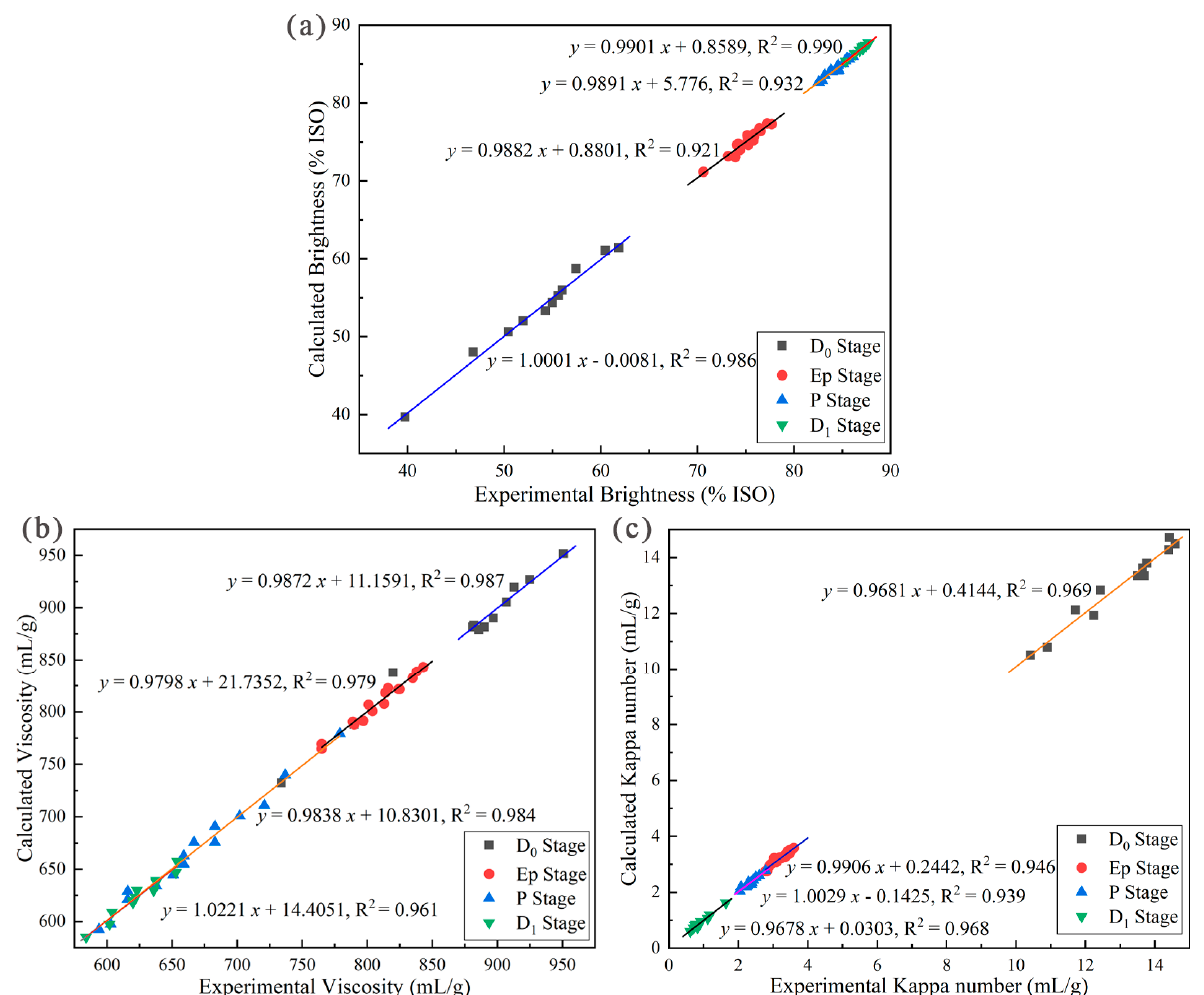
Figure 3. The relationship between the calculated and experimental value of brightness ( a ), viscosity ( b ) and Kappa number ( c ).